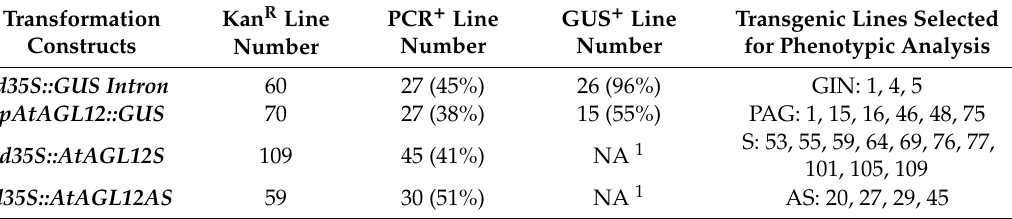
Table 1. Walnut tree transformation and transgenic line selection. The kanamycin resistant (Kan R ) Juglans sp. embryogenic lines growing after 5 subcultures on selective medium were further analyzed by molecular means to confirm their transgenic status. Only the lines showing two positive PCR amplifications of di ff erent T-DNA targets ( nptII and GUS or AtAGL12 ) from their genomic DNA were further considered (PCR + lines). When relevant, the numbers of line showing positive GUS staining are given (GUS + ). In the end, the transgenic lines selected for phenotypic analysis are